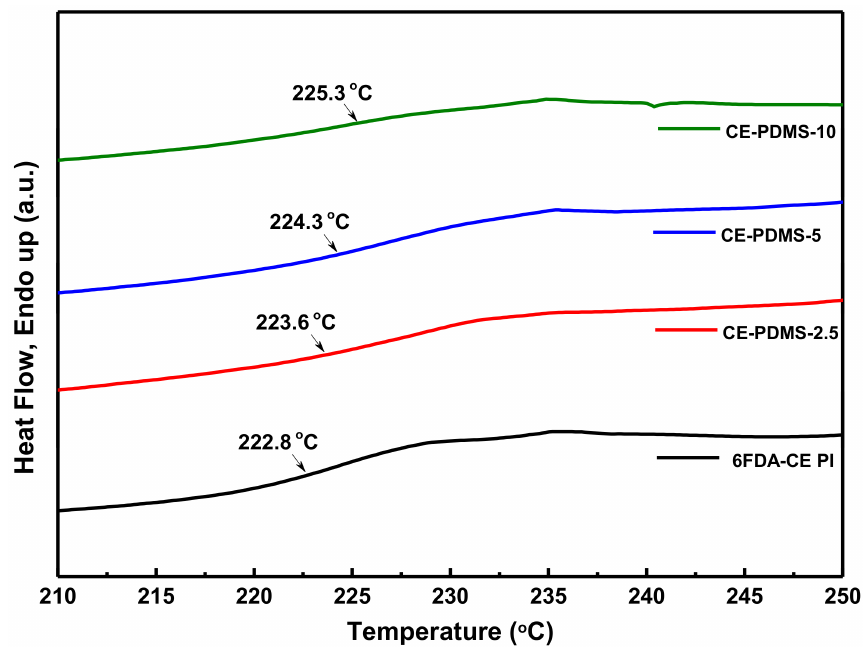
Figure 3. DSC curves and Tg values in CE-PDMS-x